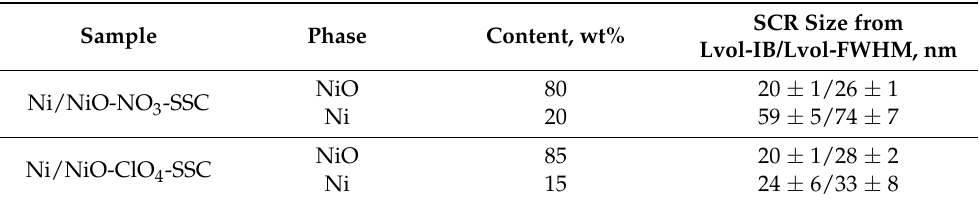
Figure 7. X-ray powder diffraction for Ni/NiO-NO 3 -SSC and Ni/NiO-ClO 4 -SSC. Table 5. Powder XRD data for the solid products of [Ni(C 3 H 4 N 2 ) 6 ](NO 3 ) 2 and [Ni(C 3 H 4 N 2 ) 6 ](ClO 4 ) 2